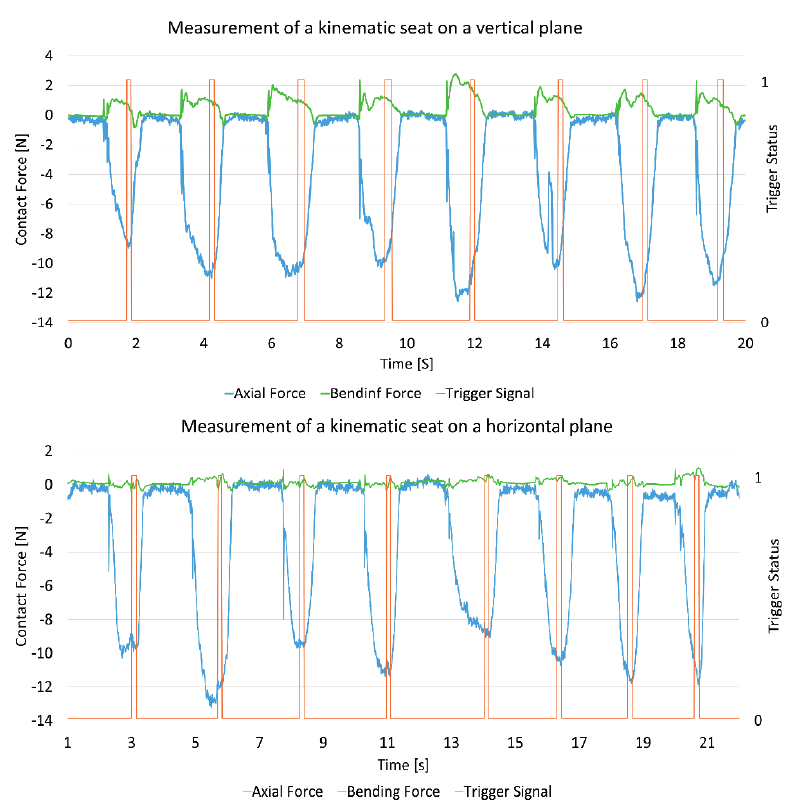
Figure 10. Examples of force readings when measuring kinematic seats. Trigger, axial and bending curves for ( Top ) vertical plane and ( Bottom ) horizontal plane.